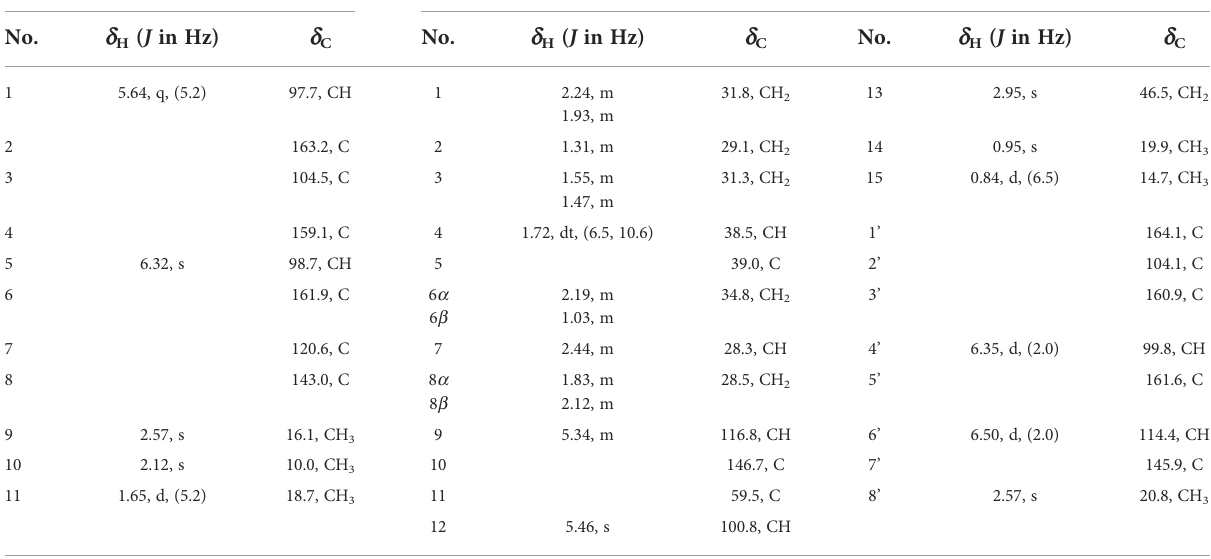
TABLE 1 1 H (500 MHz) and 13 C (125 MHz) NMR data of 1 and 2 in CD 3 OD ( d in ppm, J in